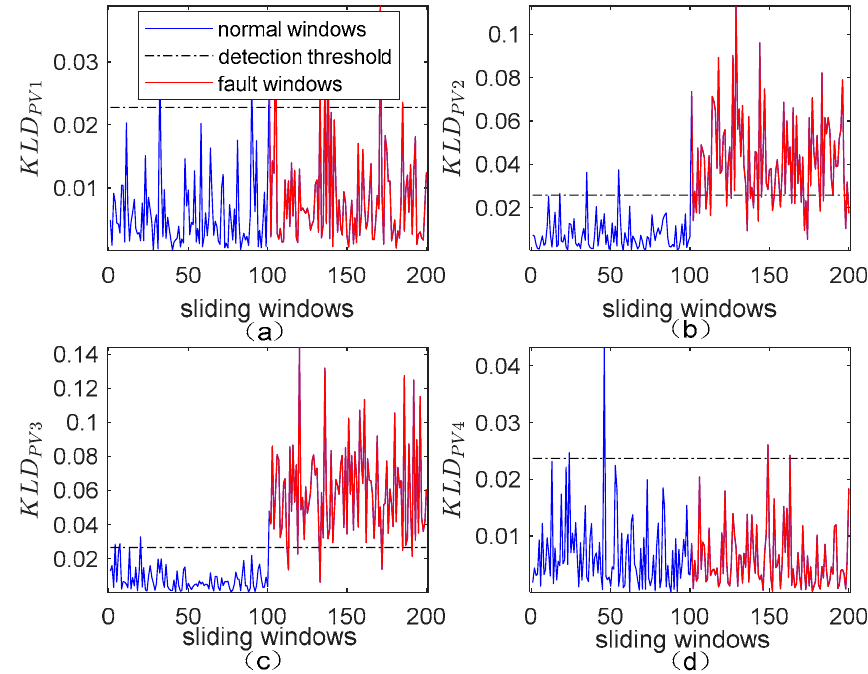
Figure 4. The results of detecting the incipient fault f 1 by using the principal component analysis (PCA) + Kullback-Leibler divergence (KLD)1 method and the PCA + KLD2 method: ( a ) the result of first projection vector (PV) for the fault f 1 ; ( b ) the result of second PV for the fault f 1 ; ( c ) the result of third PV for the fault f 1 ; ( d ) the result of fourth PV for the fault f 1